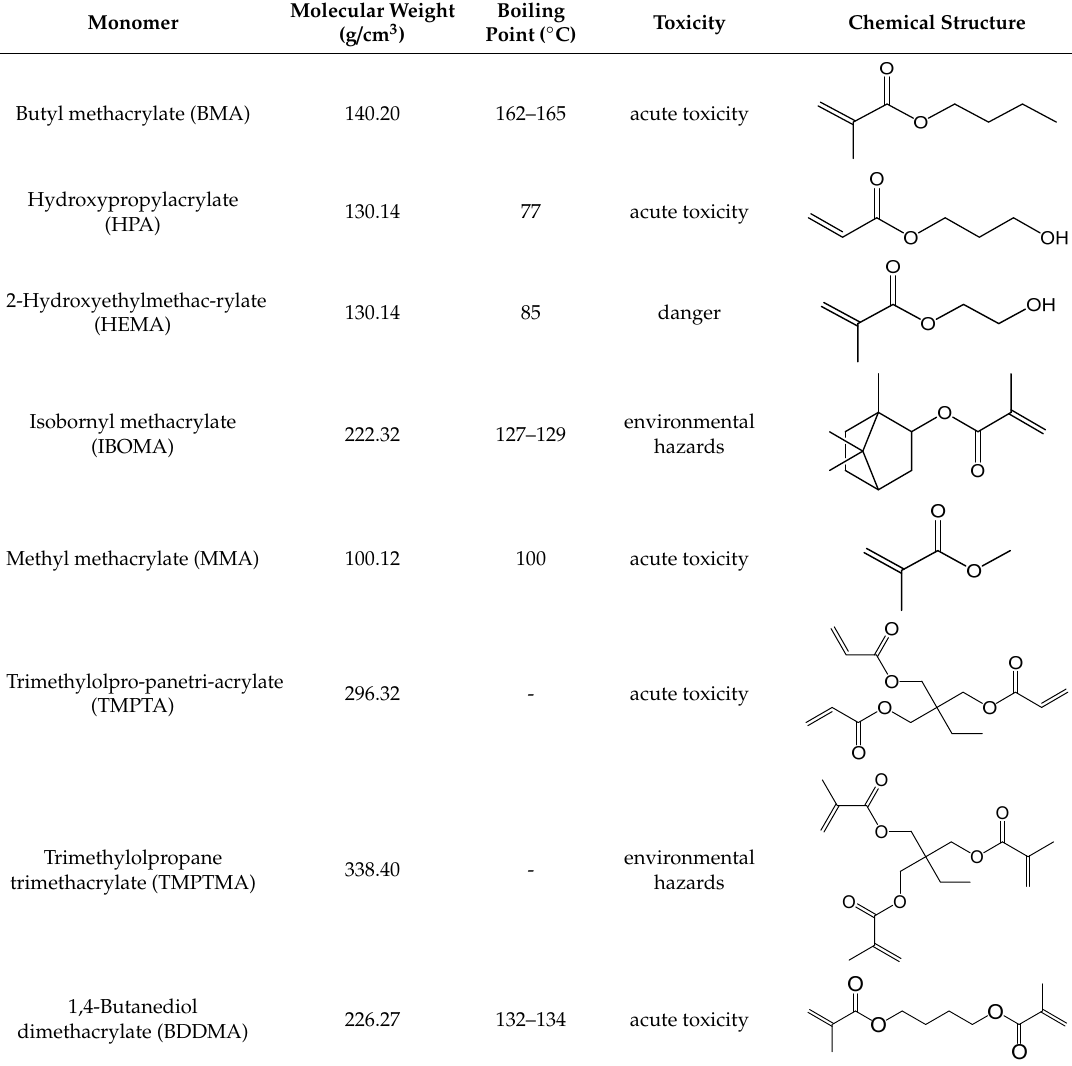
Table 2. Characteristics of commonly used (methyl)acrylate monomers.